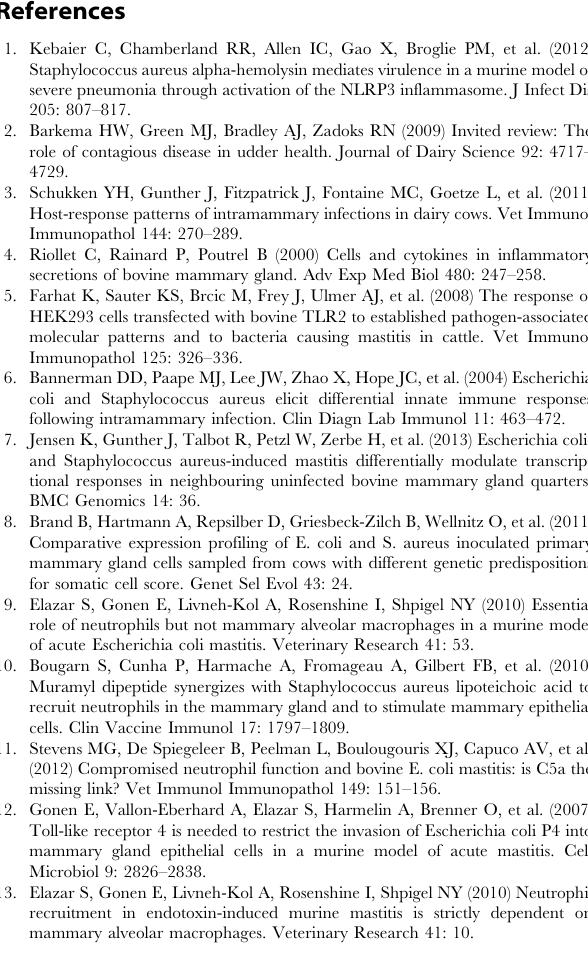
limit. Figure S2 Hepatic NF-kappaB activity in transgenic reporter mice post-IMI with E. coli or S. aureus . (A) In vivo imaging follow-up of NF-kappaB activity in the liver (ventral view) after an IMI with E. coli or S. aureus . The data represents the flux density (total flux radiance per selected body area (in p*(s*m 2 ))). (B) Representative photograph of lactating mice (most left) compared to sham-inoculated (PBS, 2nd from left) mice at 24 h post-IMI with S. aureus (3rd from left), or E. coli (most right). The intensity of luminescence was scaled based on the radiance (in p*(s*m 2 )). (C) Livers of NF-kappaB reporter mice were excised at 12 h and at 24 h post-IMI, and their luminescence was measured ex vivo. The graph represents the total flux radiance per area (in p*(s*m 2 )) as a measure for the NF-kappaB activity. (D) Represen- tative photographical view of excised livers post-IMI with E. coli (top), S. aureus (middle) or PBS (bottom). Letters of homogeneous subsets were marked if the difference between treatments were statistically significant (P , 0.05). Figure S3 Differential nuclear translocation of mam- mary NF-kappaB p50 post-IMI with E. coli vs S. aureus